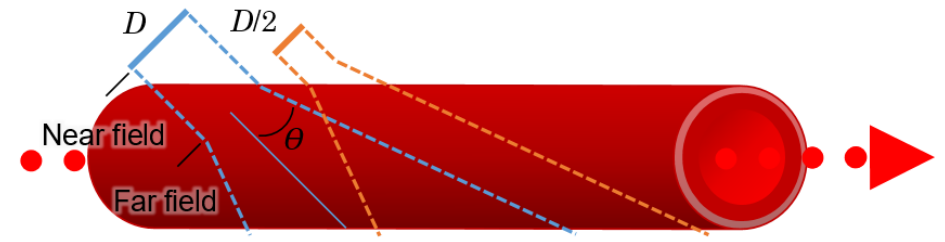
Figure 9. Representation of two ultrasonic transducers with diameters D and D /2 emitting at the same frequency. As is shown, the difference in diameters causes different fields of penetration.